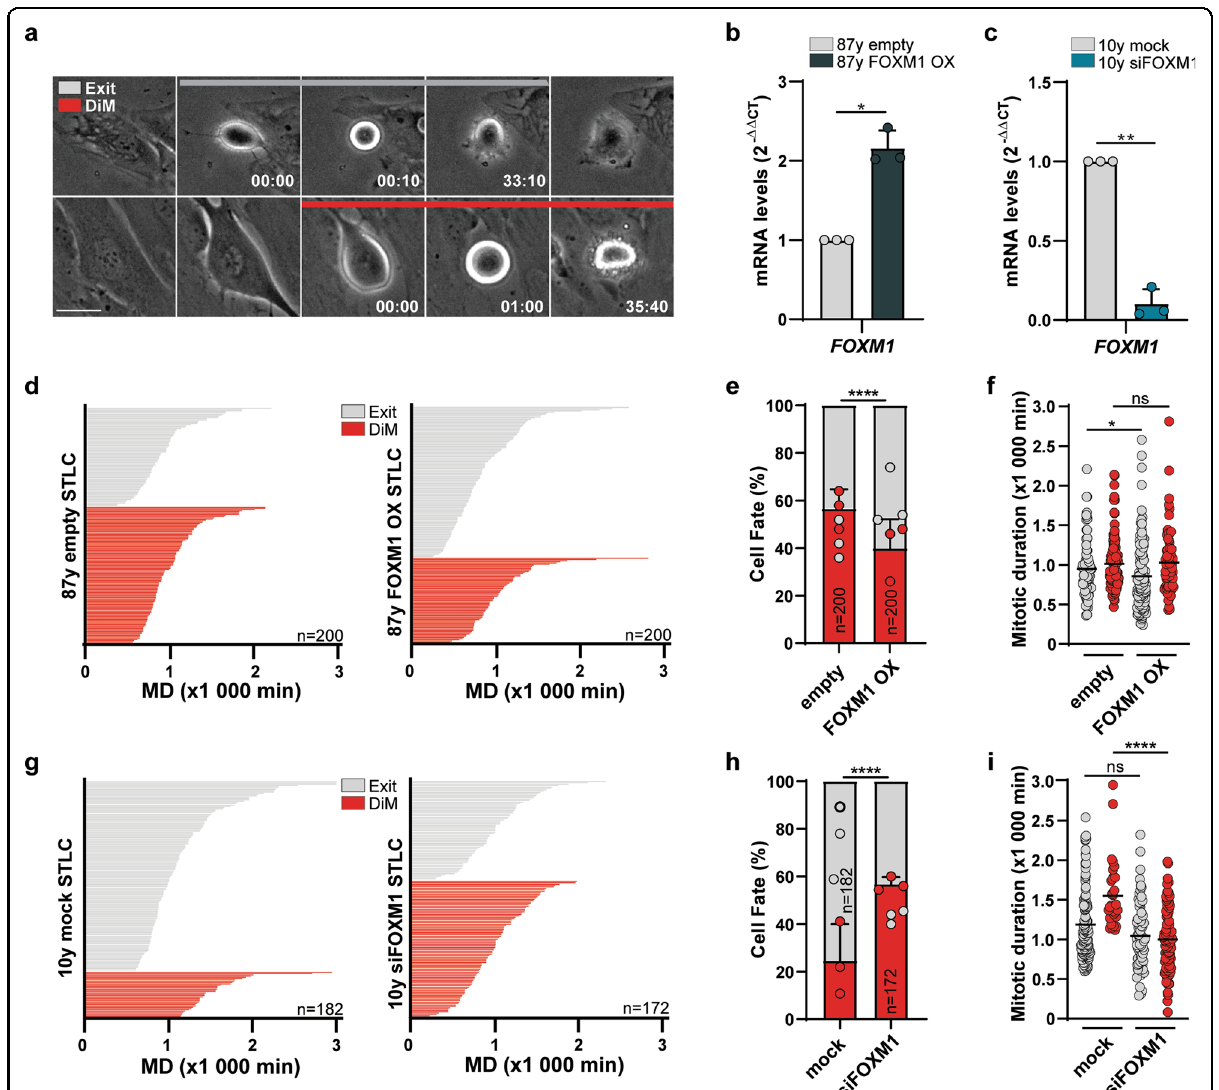
Fig. 1 FOXM1 levels modulate cell fate pro fi le in response to antimitotics. a Representative time-lapse sequences of slippage/mitotic exit (in gray) and death in mitosis (DiM, in red) cell fates of HDFs treated with antimitotics. Time in h:min, from nuclear envelope breakdown (NEB) to each cellular outcome. Scale bar, 20 µm. b FOXM1 transcript levels in 87-year-old HDFs transduced with control (empty vector) and FOXM1-overexpressing lentiviruses. c FOXM1 transcript levels in mock- and FOXM1 siRNA-depleted 10-year-old HDFs. d Individual cell fate pro fi ling (exit vs. DiM) of control (empty) ( n = 200) or FOXM1-overexpressing 87 y HDFs ( n = 200) treated with 5 µM STLC. MD, mitotic duration. e Cell fate percentage of the experiments described in d . f Mitotic duration of the individual cell fates shown in d . g Individual cell fate pro fi ling (exit vs. DiM) of mock- ( n = 182) and siFOXM1-depleted ( n = 172) 10 y HDFs treated with 5 µM STLC. MD, mitotic duration. h Cell fate percentage of the experiments described in g . i Mitotic duration of the individual cell fates shown in g . Data information: In b , c data are mean ± S.D. from n = 3 independent experiments; * p ≤ 0.05, ** p ≤ 0.01 (two-tailed paired t test). In e , h data are mean ± S.D. from n = 3 independent experiments; **** p ≤ 0.0001 (two-tailed χ 2 ). In f , i values are mean. * p ≤ 0.05, **** p ≤ 0.0001 (two-tailed Mann – Whitney